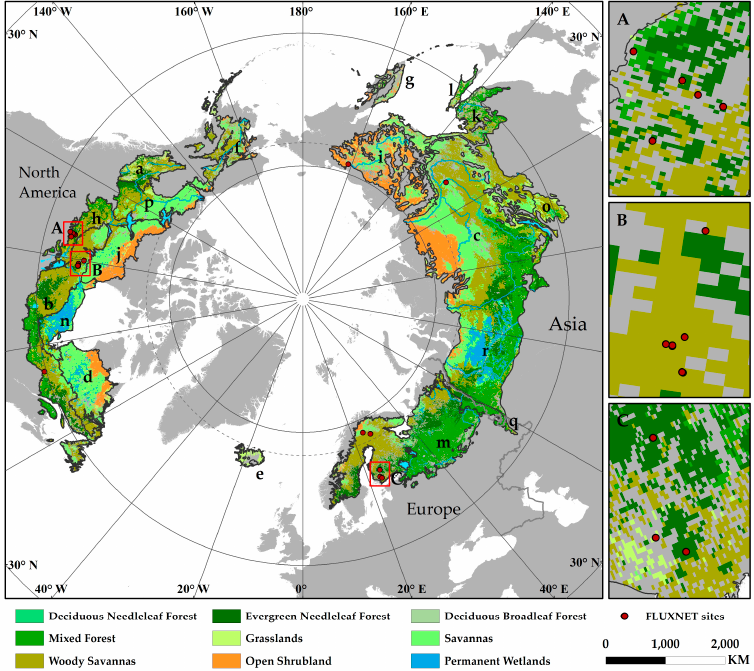
Figure 2. Location the study area and spatial distribution of the main land cover types (unchanged from 2001 to 2017). The maps on the right are enlarged views of the local FLUXNET sites.